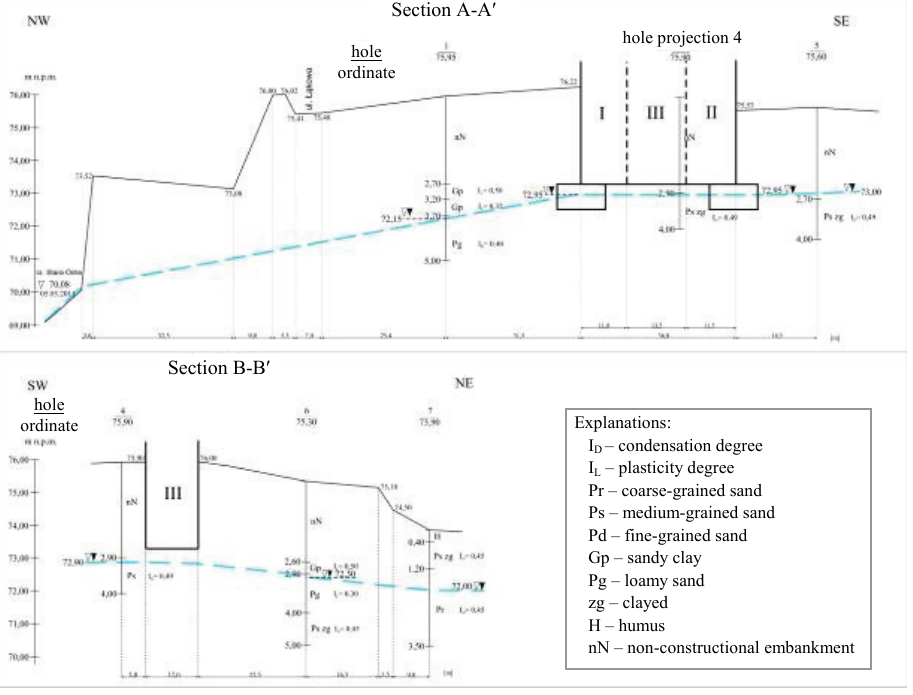
Fig. 3. Geological and engineering cross